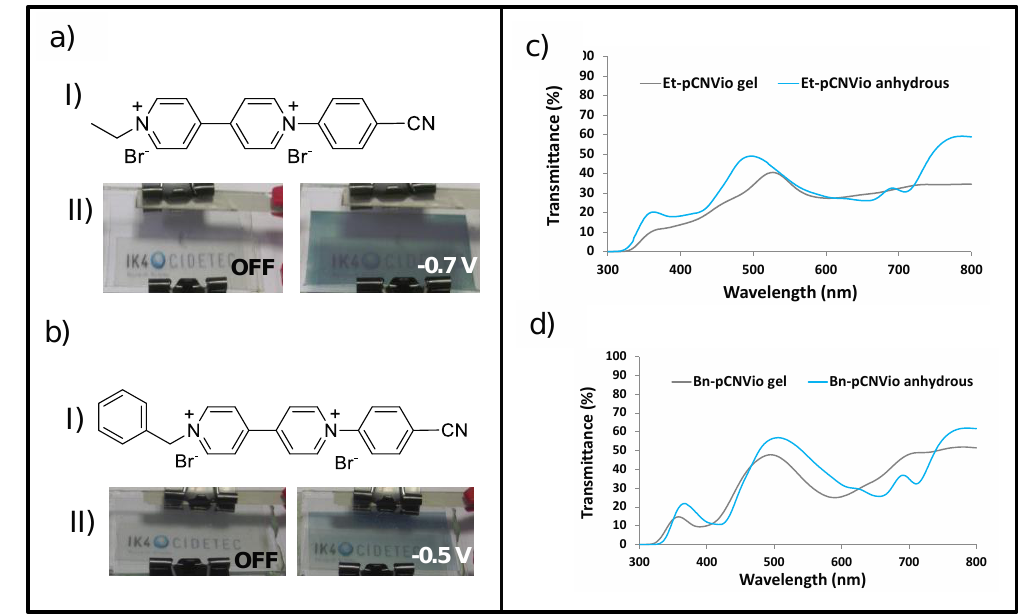
Figure 9. Gel-EC systems based on asymmetric viologens. ( a ) ECD comprising 1-ethyl-1′-( p -cyanophenyl)-4,4′-bipyridinium dibromide (Et-pCNVio); ( I ) chemical structure of Et-pCNVio and ( II ) photographs of the corresponding ECD at bleached (off) and gray-colored state (−0.70 V). ( b ) ECD comprising 1-benzyl-1′-( p -cyanophenyl)-4,4′-bipyridinium dibromide (Bn-pCNVio); ( I ) chemical structure of Bn-pCNVio and ( II ) photographs of the corresponding ECD at bleached (off) and gray-colored state (−0.50 V). Transmittance profiles of ECDs containing ( c ) Et-pCNVio and ( d ) Bn-pCNVio gels vs. corresponding anhydrous formulations in their colored states. Adapted with permission from [155], copyright (2016) American Chemical Society.